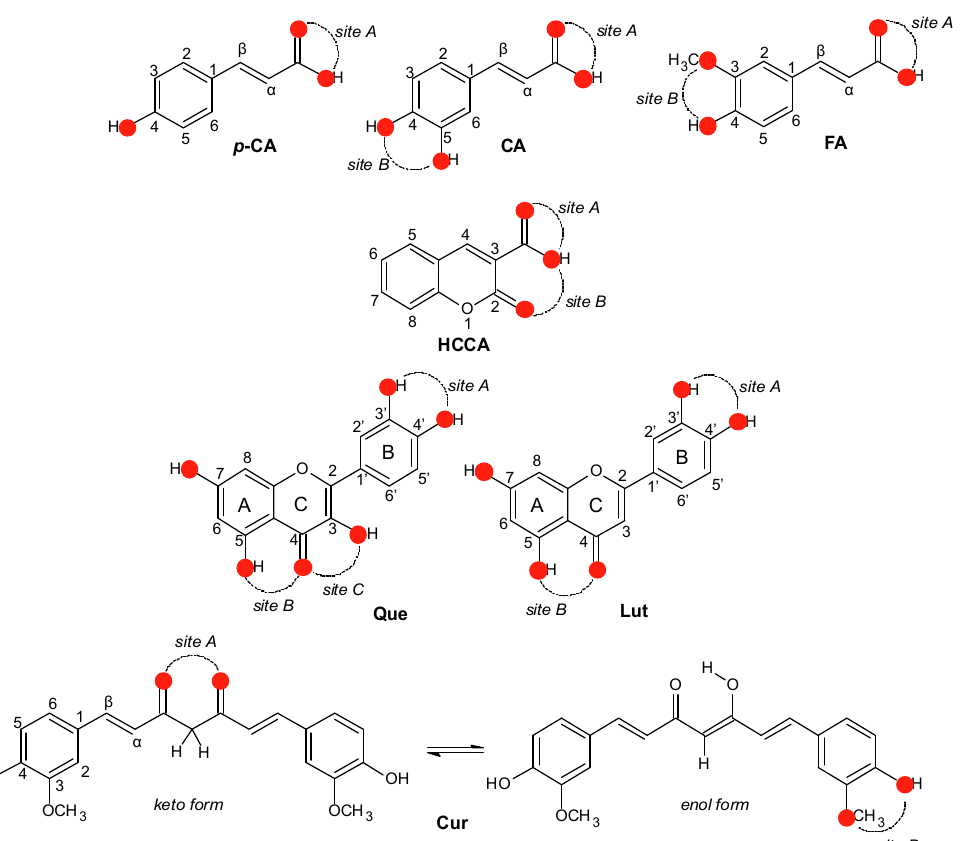
Scheme 1. NAMs considered here for coordination of Al(III) and Fe(III) ions: p ‐ coumaric ( p ‐ CA), caffeic (CA), ferulic (FA), and coumarin ‐ 3 ‐ carboxylic (HCCA) acids, quercetin (Que), luteolin (Lut), and curcumin (Cur). All the potential binding sites are highlighted with red circles and dashed arcs.